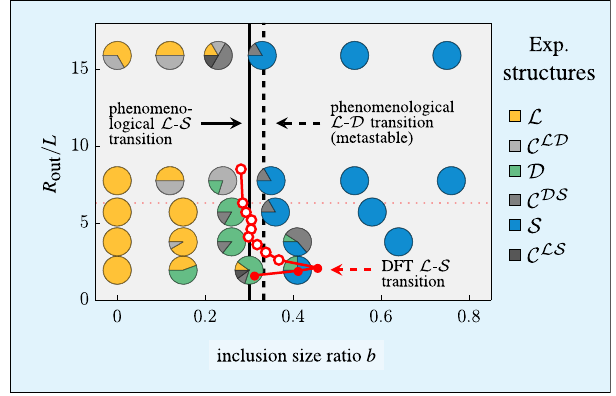
Fig. 3 Topological state diagram. Shown are the stable states for different outer radii R out and inclusion size ratios b = R in / R out . The large pie charts indicate the percentage at which each state occurs in the experiment according to the legend. The small circles denote the theoretical laminar- Shubnikov ( LS ) transition (the numerical error is of the order of the symbol size; fi lled circles indicate that no laminar state can exist for larger inclusions). The vertical lines represent a possible scenario (see labels) predicted by a phenomenological model based on defect energies. Theoretical source data are provided as a Source Data fi le.